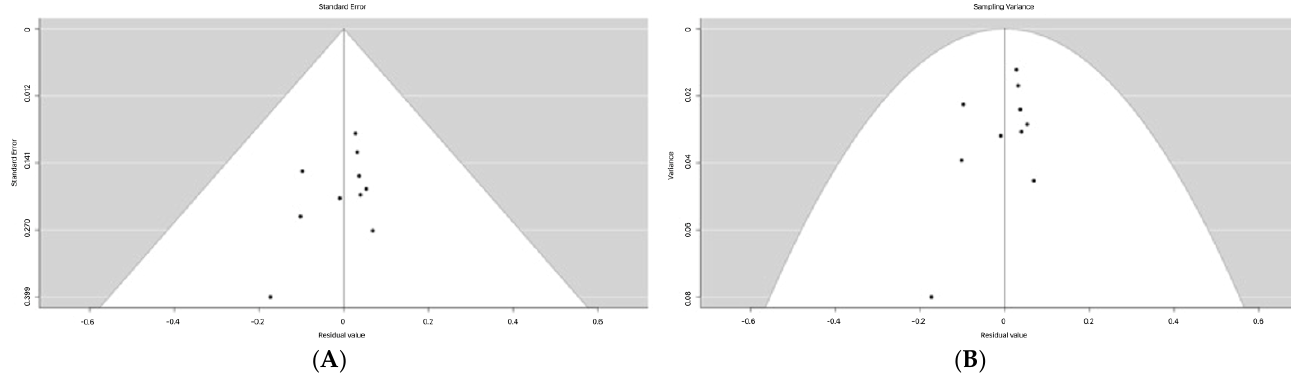
Figure 2. Funnel plots: Individual residual post-modeling on the x-axis against the corresponding standard errors (y-axis, in decreasing order) ( A ) and sampling variance or standard error ( B ). NB. In the absence of publication bias and heterogeneity, the points form a funnel shape, with the majority of the points falling inside of the pseudo-confidence region with bounds θ ± 1.96SE, where θ is the estimated effect or outcome based on the fixed-effects model and SE is the standard error value from the y-axis.